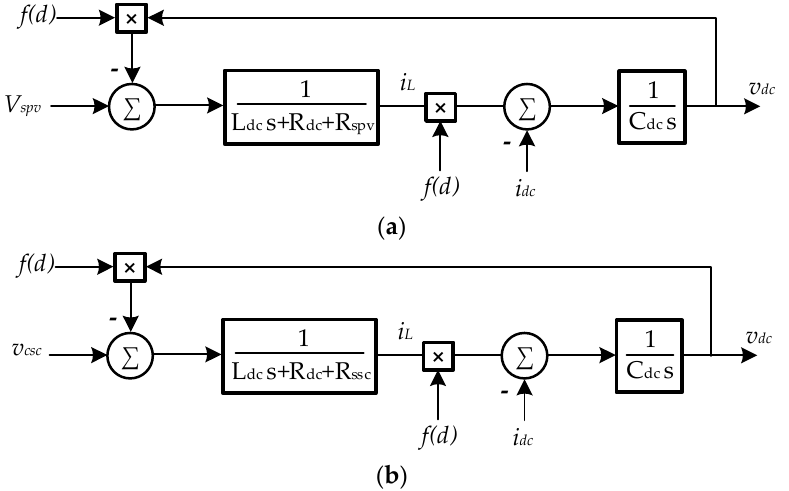
Figure 9. The diagram of the nonlinear model of the BDC combined with: ( a ) PV and ( b ) SC models.